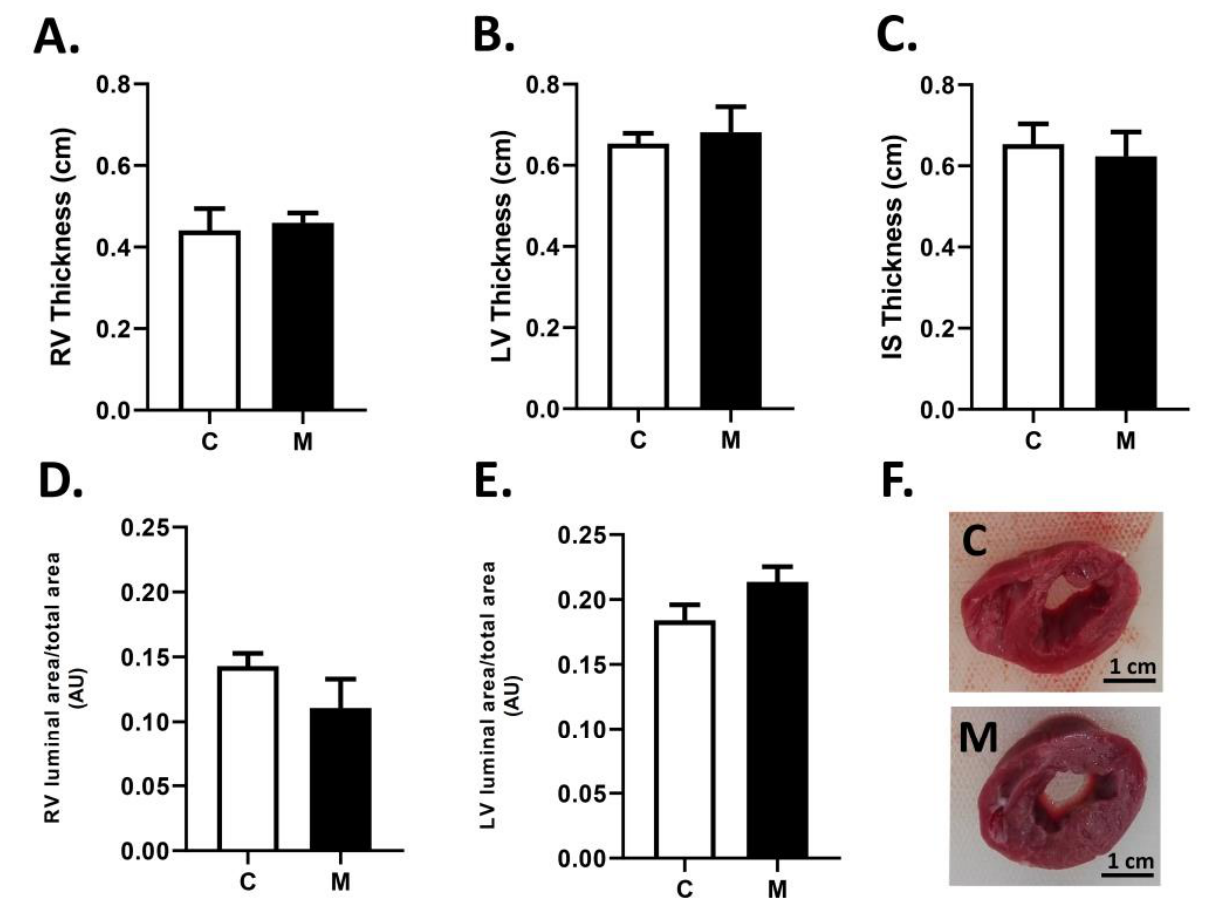
Figure 2. Cardiac biometry at the end of the experimental period. Thickness of right ventricle free wall (RV, ( A )), left ventricle free wall (LV, ( B )) and interventricular septum (IS, ( C )); luminal:total area ratios for the right ( D ) and left ( E ) ventricles, at 29 days old. Representative images are shown ( F ). Bar in the photographs = 1 cm. Groups are control (C, white bars) and melatonin treated (M, black bars) lambs. Data expressed as mean ± S.E.M.